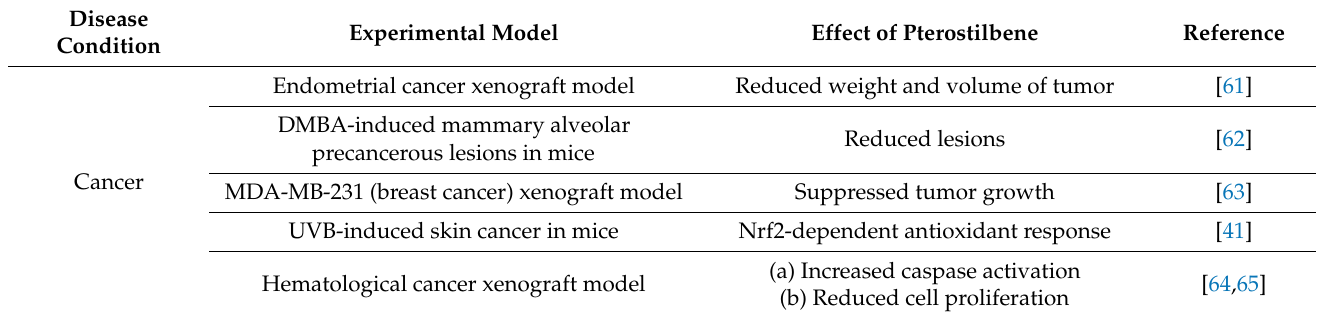
Table 2. Effect of Pterostilbene in Experimental Models of Various Disease Conditions.